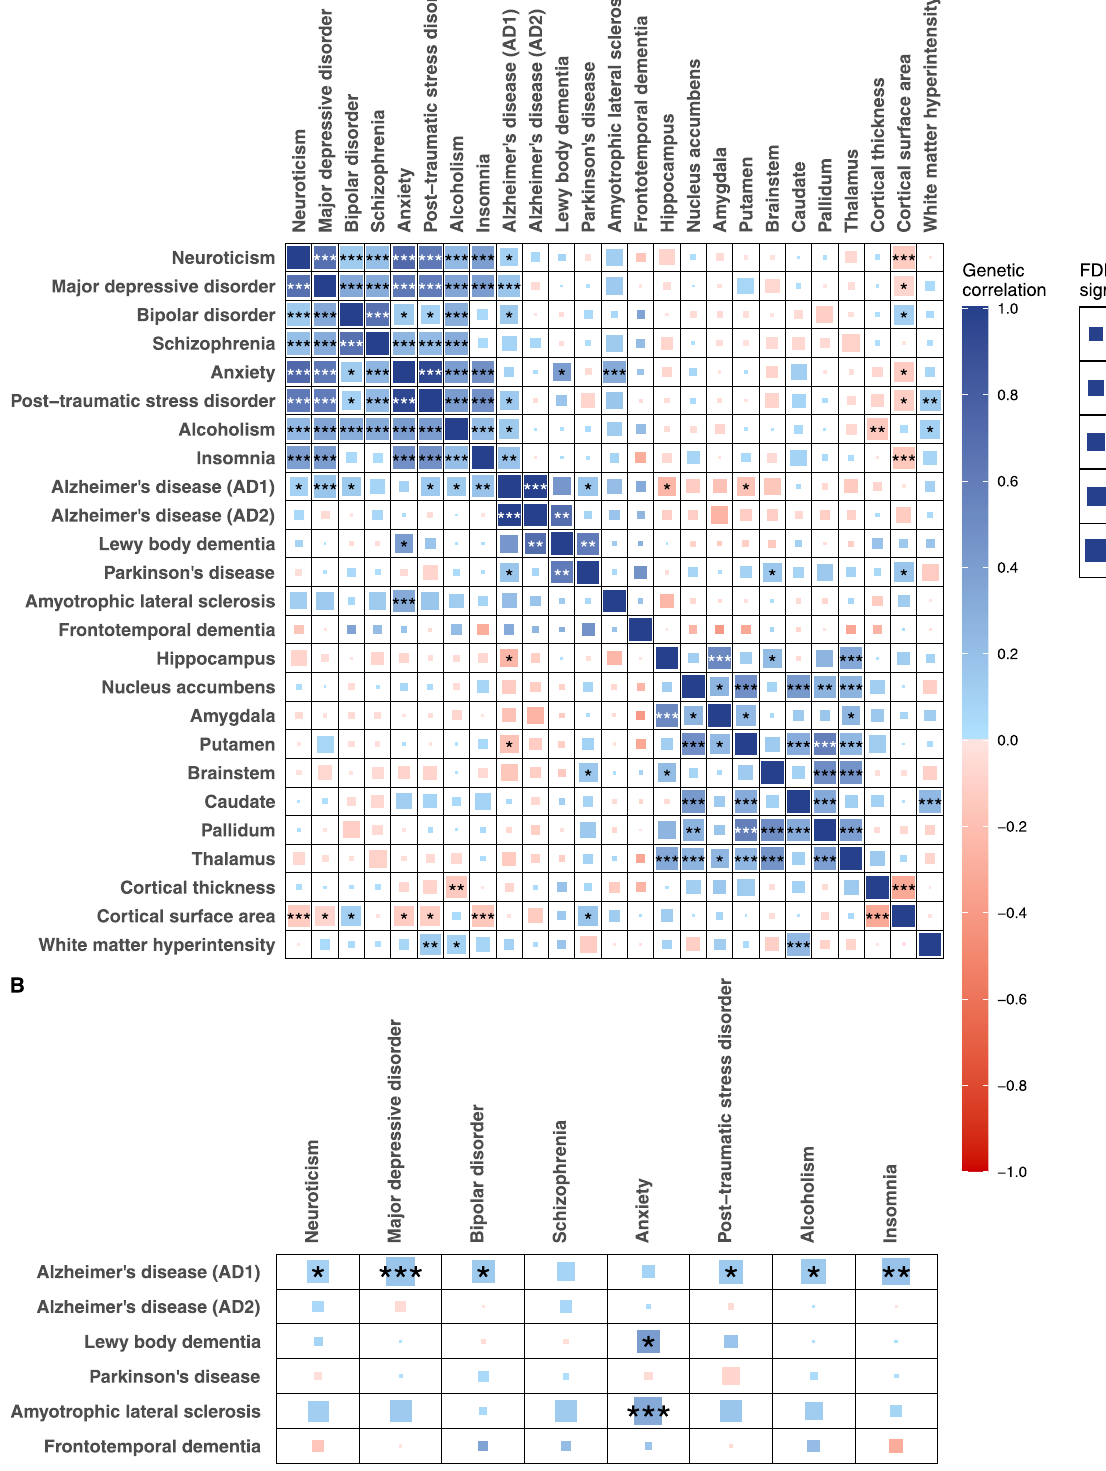
magnitude and direction of correlation. The size of the colored square re fl ects the magnitudeof the p value. The asteriskindicatesFDR p value: *FDR p <0.05;**FDR p <0.01, *** FDR p <0.001. The exact p values are provided in Table